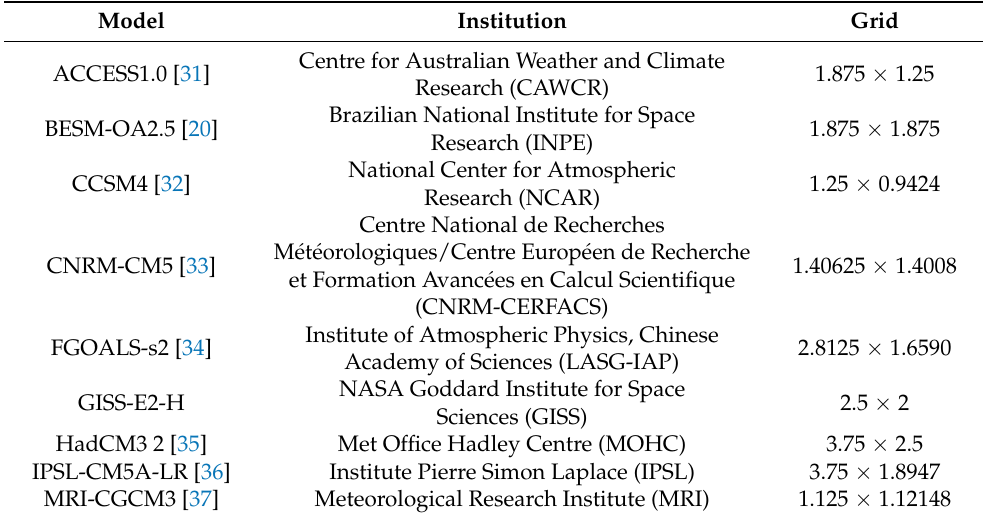
Table 1. CMIP5 models used in this study. Grid refers to atmospheric horizontal spacing (longitude × latitude, in degrees). Model Institution Grid ACCESS1.0